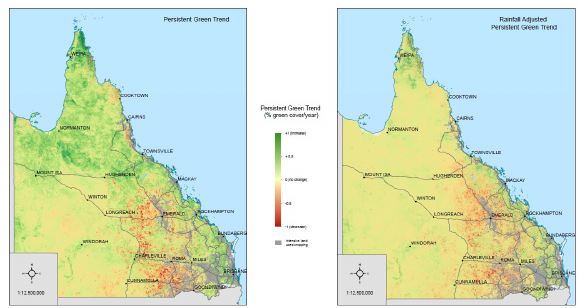
Figure 3. Persistent green trends in Queensland. The map on the left shows the trend in persistent green vegetation over the Landsat time-series (~28 years). Green areas show a slight increase in persistent green vegetation, red areas slight decreases in persistent green vegetation. The map on the right shows the persistent green trend adjusted for rainfall. This map suggests that rainfall accounts for a large proportion of the increases seen in persistent green vegetation. The decreases are still evident and indicative of land cover changes and vegetation clearing associated with development in the